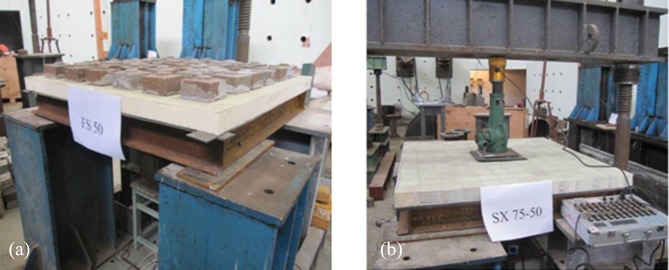
Test loading device.(a) Uniform loading. (b) Concentrated loading.